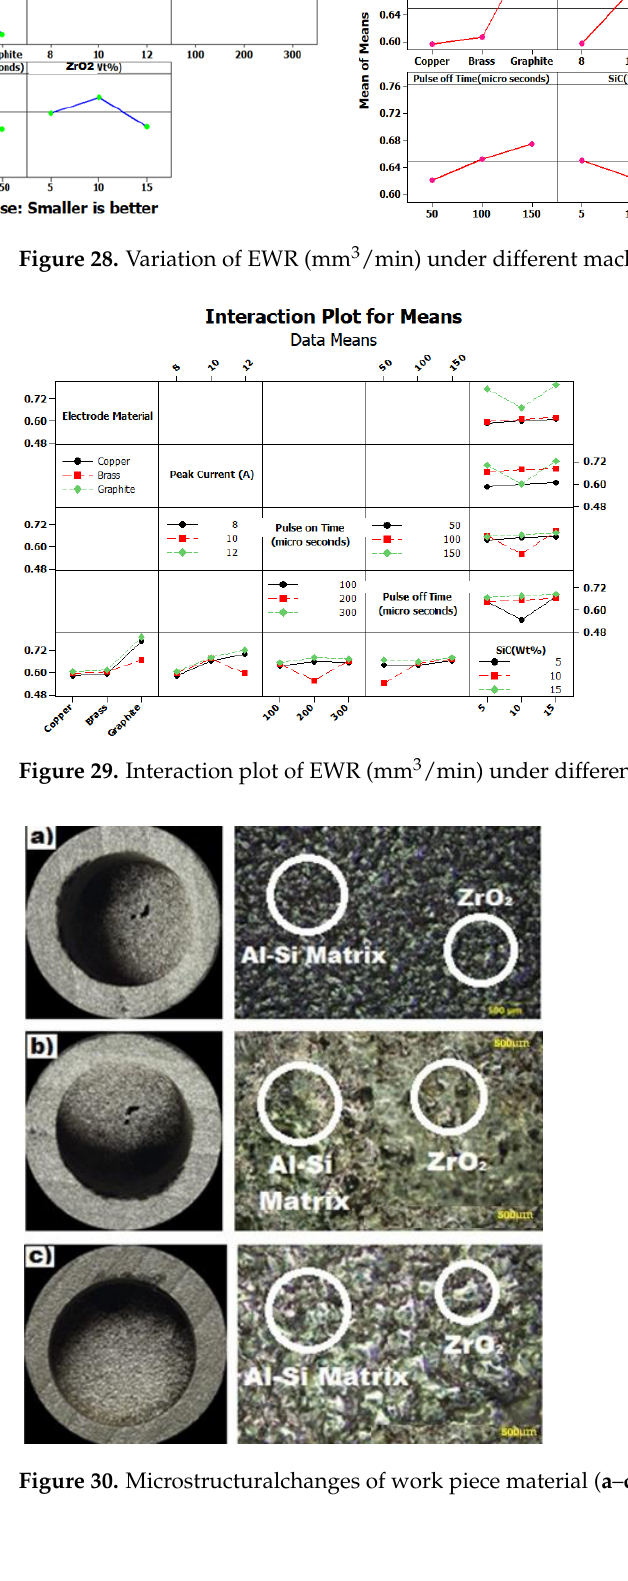
Figure 31. Microstructural changes of electrode material ( a – c ).